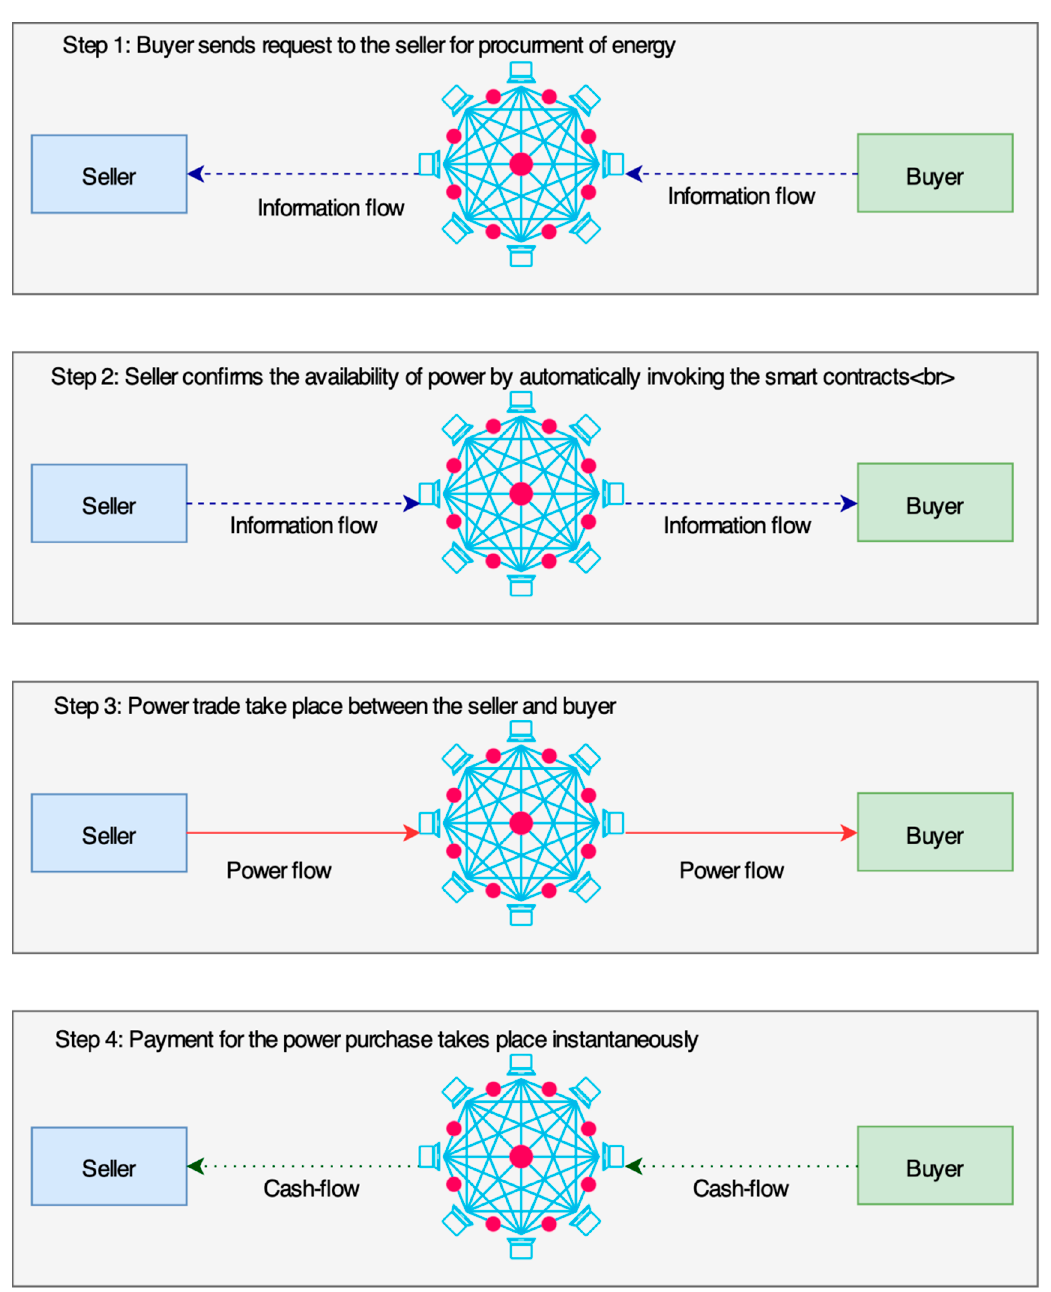
Figure 9. Step-by-step clearance of real-time blockchain based energy market.